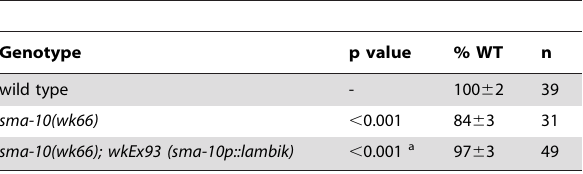
Table 4. Drosophila lambik rescues the body size defect of sma-10(lf)